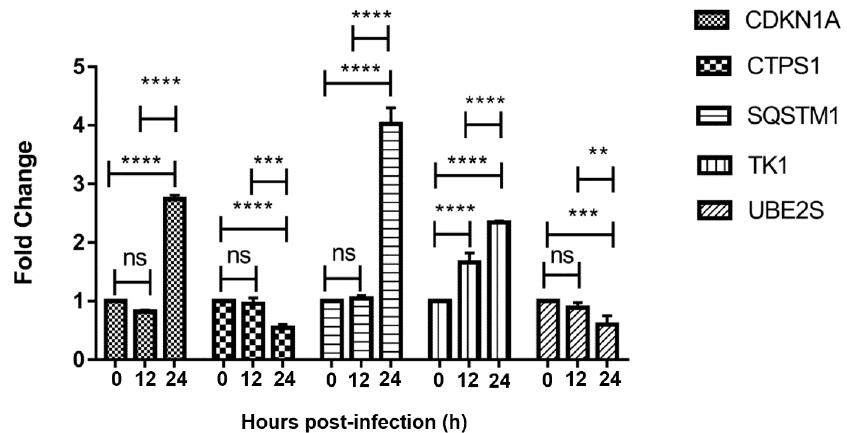
Figure 2. qRT-PCR verification of CDKN1A, CTPS1, SQSTM1, TK1, and UBE2S. ns, not significant;